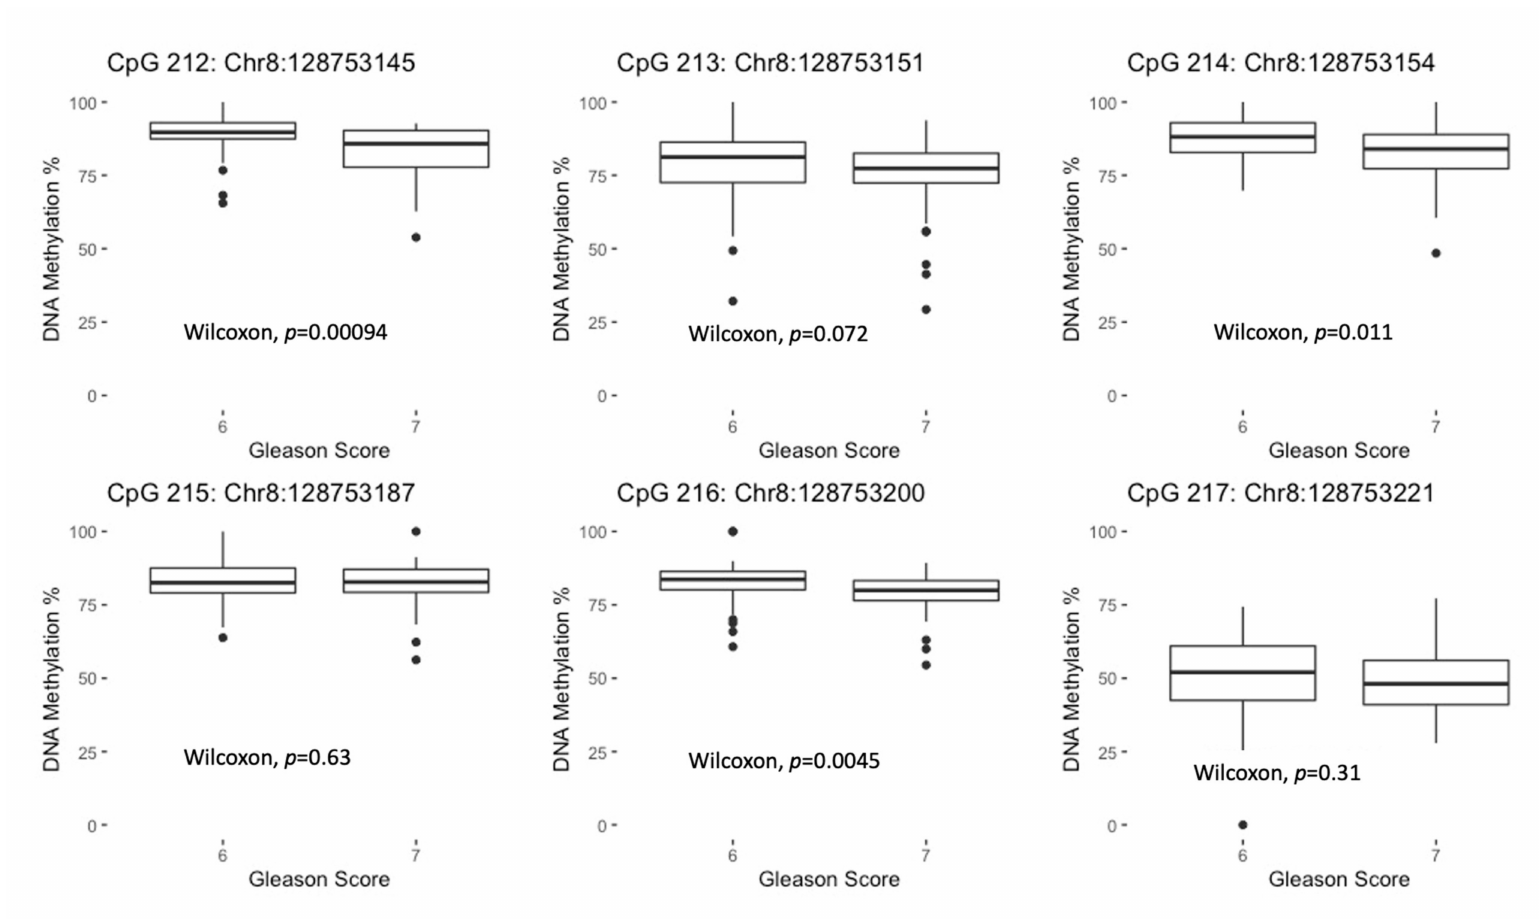
Figure 2. Box plots displaying the median % DNA methylation and interquartile range (25th: 75th percentiles) for MYC CpG sites by GS in the University of Maryland prostate tumor samples ( n =